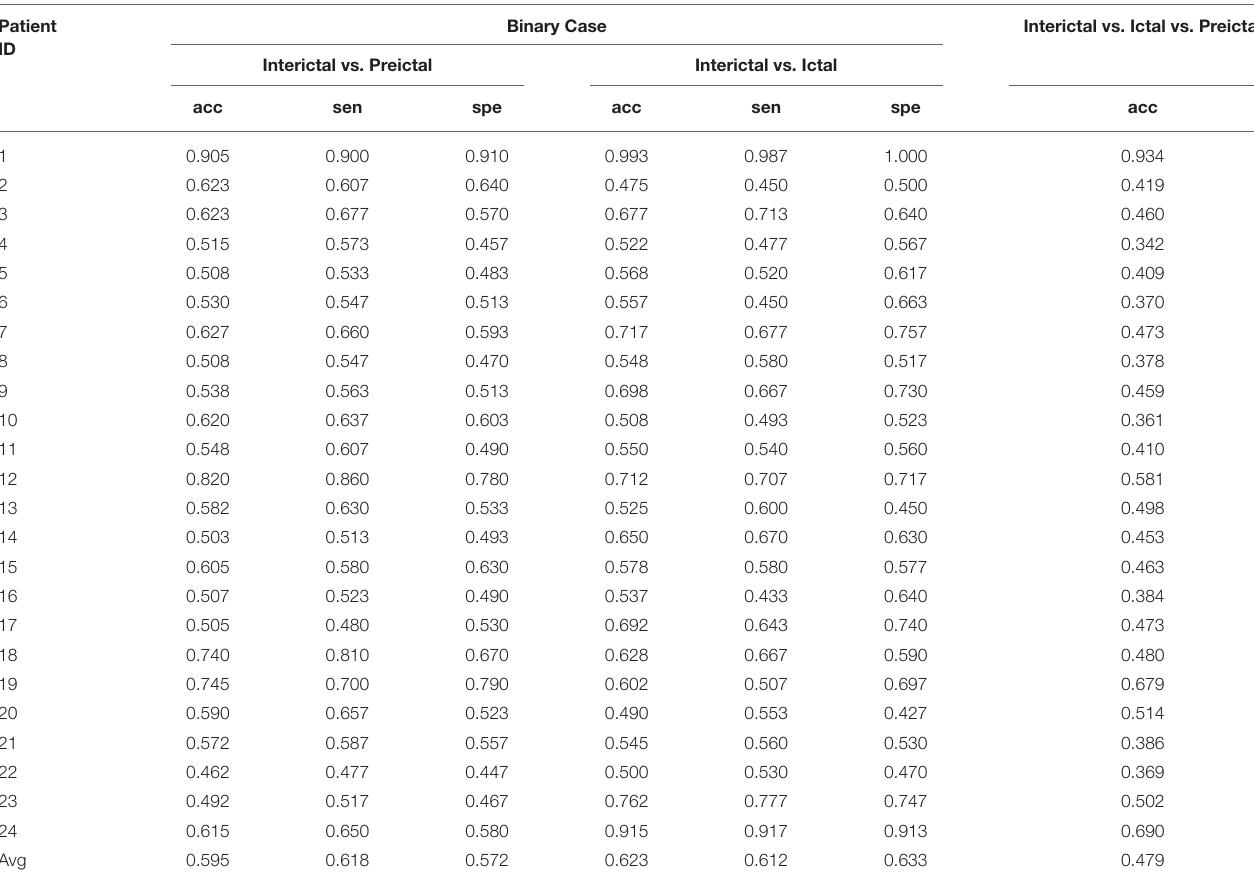
TABLE 4 | Time domain signal results for all patients in the CHB-MIT database. Patient